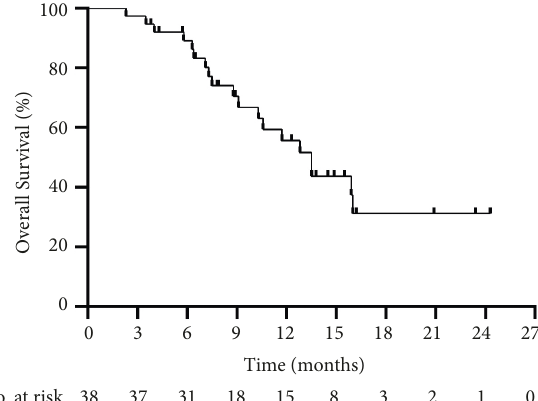
Figure 3: Kaplan–Meier curve of the overall survival time of all patients.